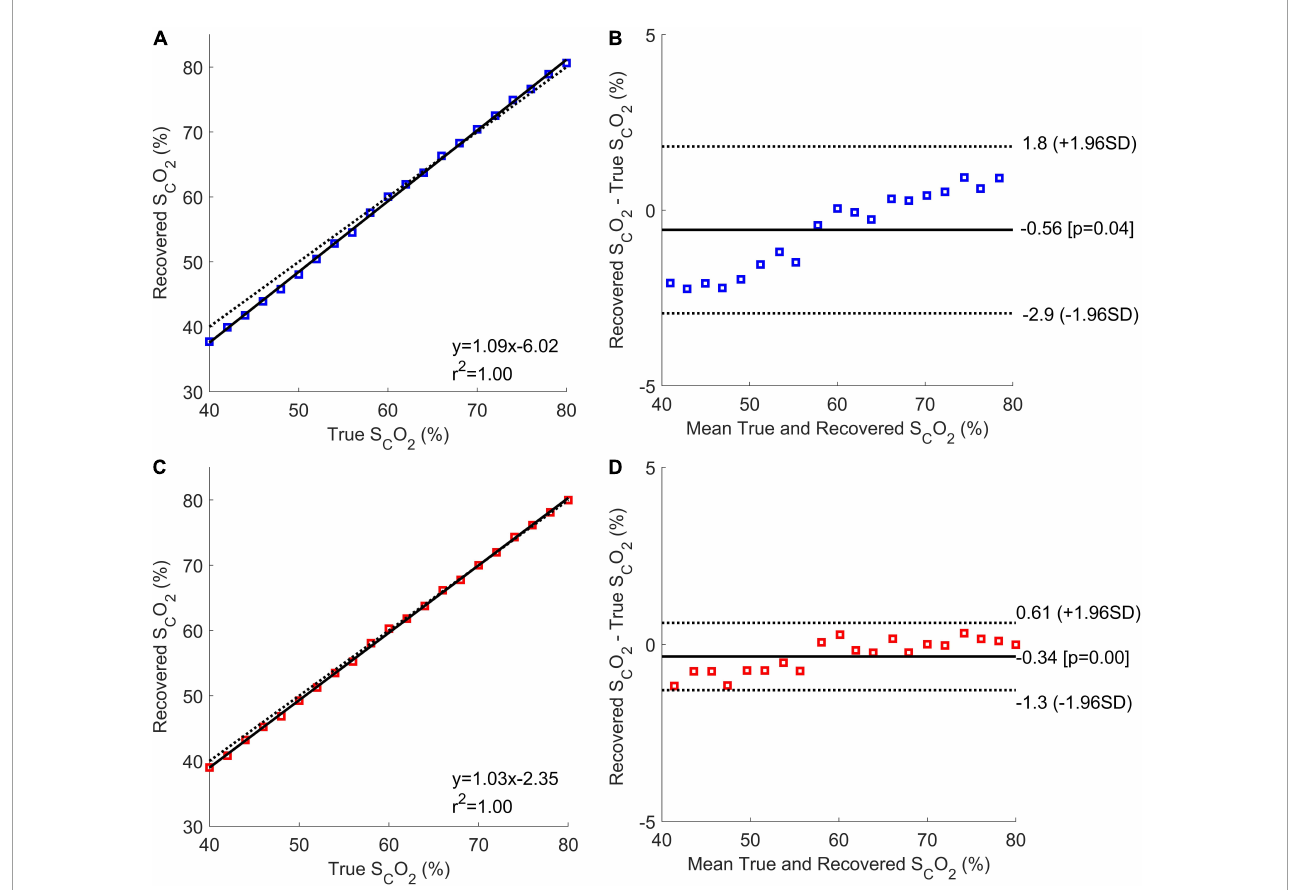
FIGURE6 Correlation and Bland-Altman plots for the Phase 1 results with unknown ( A,B , respectively; blue), and known ( C,D , respectively; red) ECL thicknesses. The correlation plots show the mean estimated cerebral oxygen saturation for every true brain oxygen saturation (coloured squares), the line of best fit (solid black line), and the expected values (dotted black line).